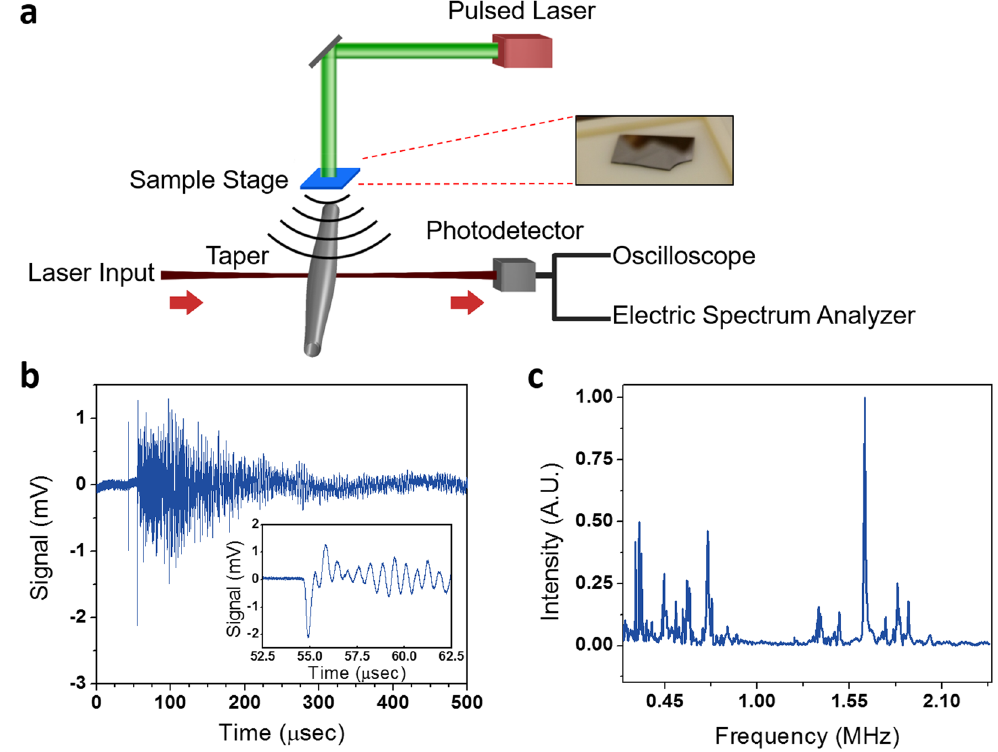
Figure 6. ( a ) Schematic of the PA detection setup. A 6 ns pulsed laser at 532 nm was impinged onto a 200 nm thick Cr film deposited on a silica wafer (see Inset) to generate PA signal. ( b ) Temporal air-coupled PA signal detected by a ring resonator ( a = 80 μ m, t = 11 μ m). The data were averaged 64 times. Inset: The “ringing” response can be seen after the initial peak signal. ( c ) Frequency response of the ring resonator towards PA signal. Frequency dependent absorption in air has been taken into account. A strong peak at 1.65 MHz and small side peaks were